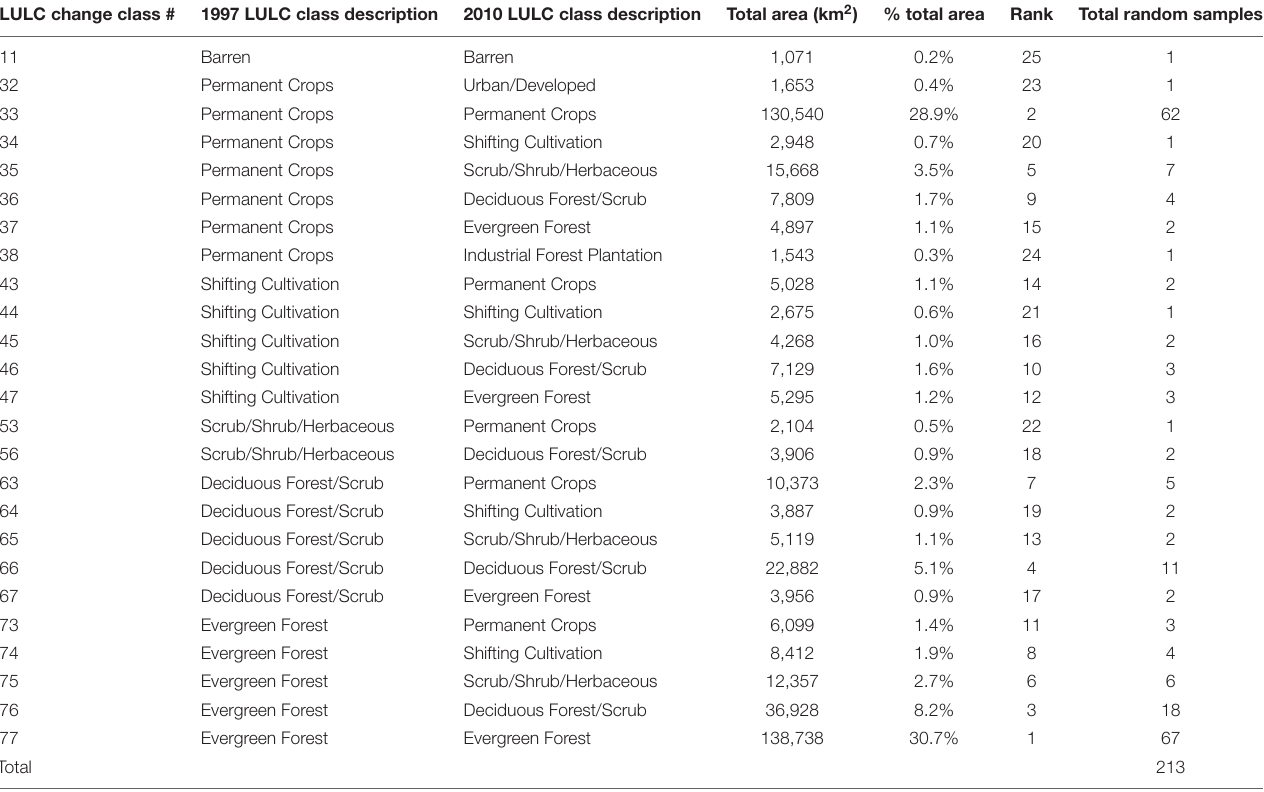
TABLE 2 | Total area for the 25 most common change classes of the 1997–2010 LULC change map, along with # samples drawn per class. LULC change class